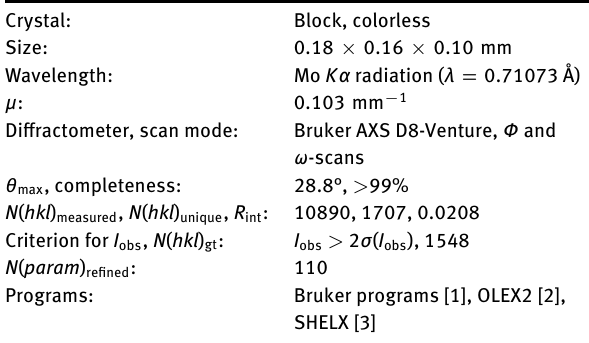
Table 2: Fractional atomic coordinates and isotropic or